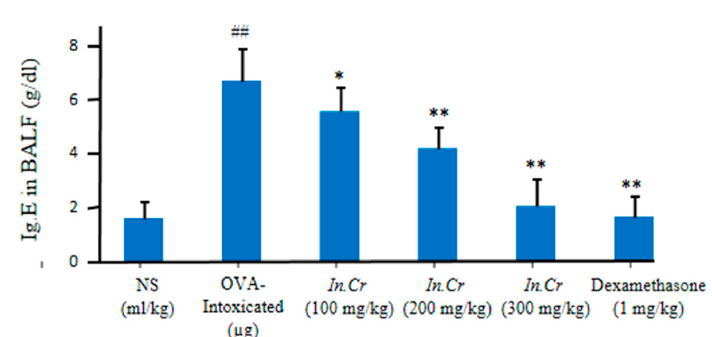
Figure 7. Per oral administration of In.Cr significantly diminished ( p < 0.05) the ranks of IgE anti- body at 100 mg/kg. In.Cr at higher doses more significantly ameliorated IgE, even though the ovalbumin (OVA)-tested group had significant escalation in the points of antibodies. # # p < 0.05 and ** p < 0.05 are more significant while * p < 0.01 is significant ( n = 8).